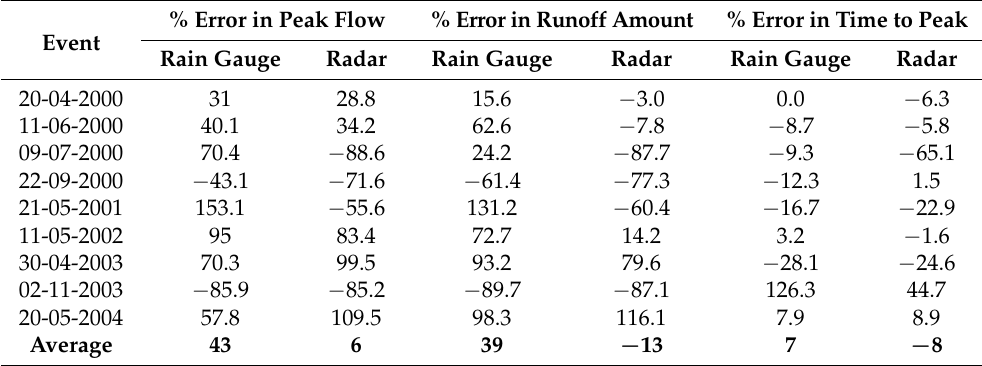
Table 3. Statistical comparison between observed and simulated peak flow rate, runoff amount, and time to peak using best estimated SCS model parameters.